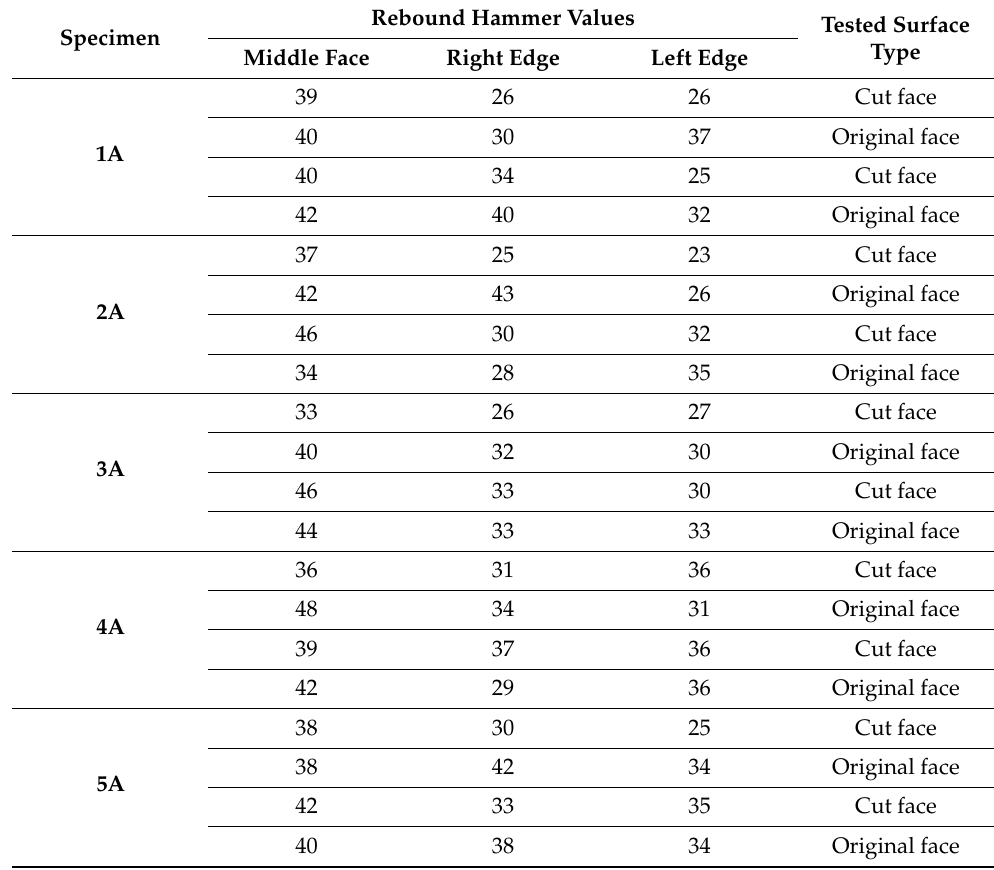
Table 4. The rebound value at test